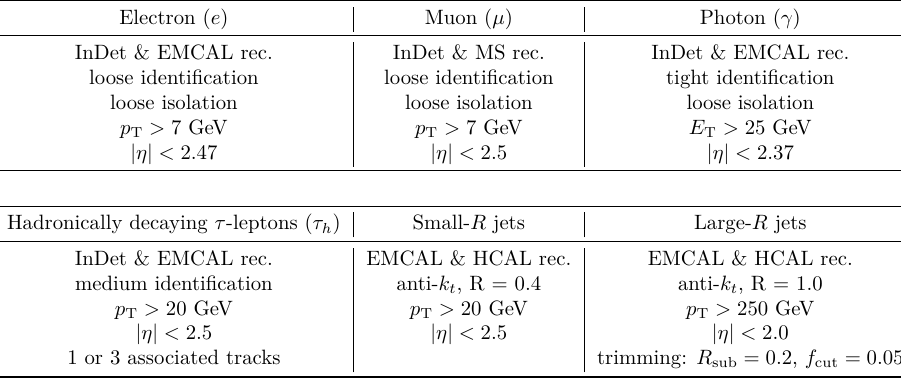
Table 1: Preselection requirements for electron, muon, photon, hadronically decaying (cid:28) -lepton, small- R -jet and large- R -jet candidates within the 13 TeV ATLAS Open Data. Reconstruction (rec.), identification and isolation criteria of the objects, as well as other additional requirements are given in Ref.